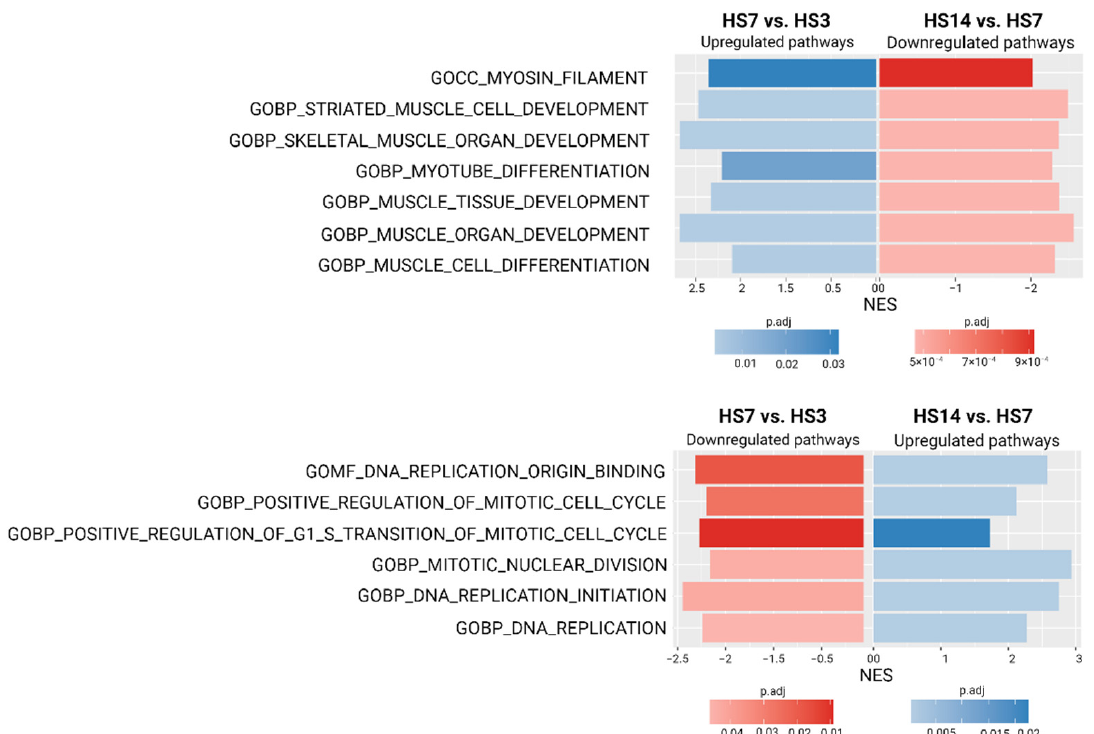
Figure 6. The fast gene set enrichment analysis (FGSEA) of all identified genes using the GO Biological Process database. Results visualized as bar plot of normalized enrichment score (NES) that display significant up/downregulated pathways that regulate the progress of cells through the cell cycle and the activation of the myogenic program in the early and late stages of unloading.